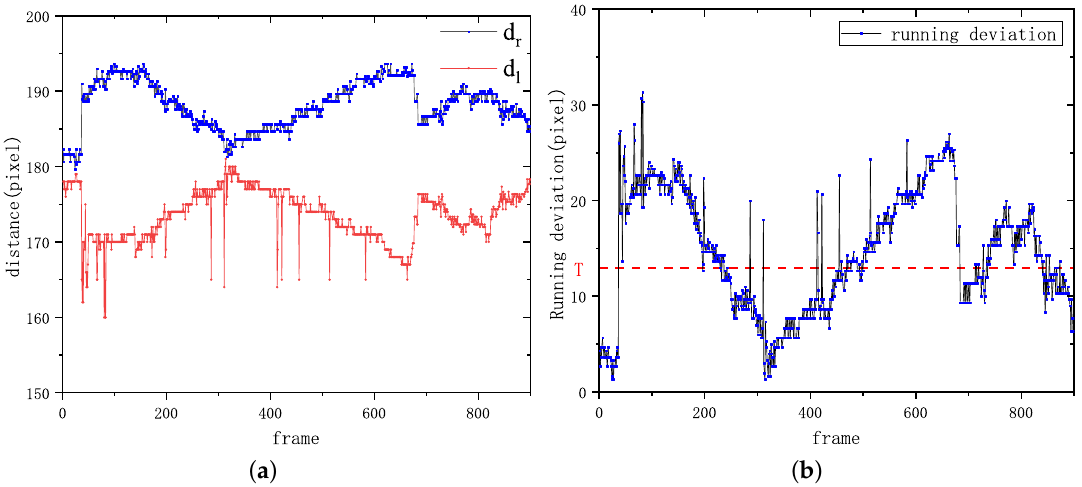
Figure 8. Image processing results using Method 2: ( a ) the distance between the left and right boundary to center line, ( b ) the difference between the two